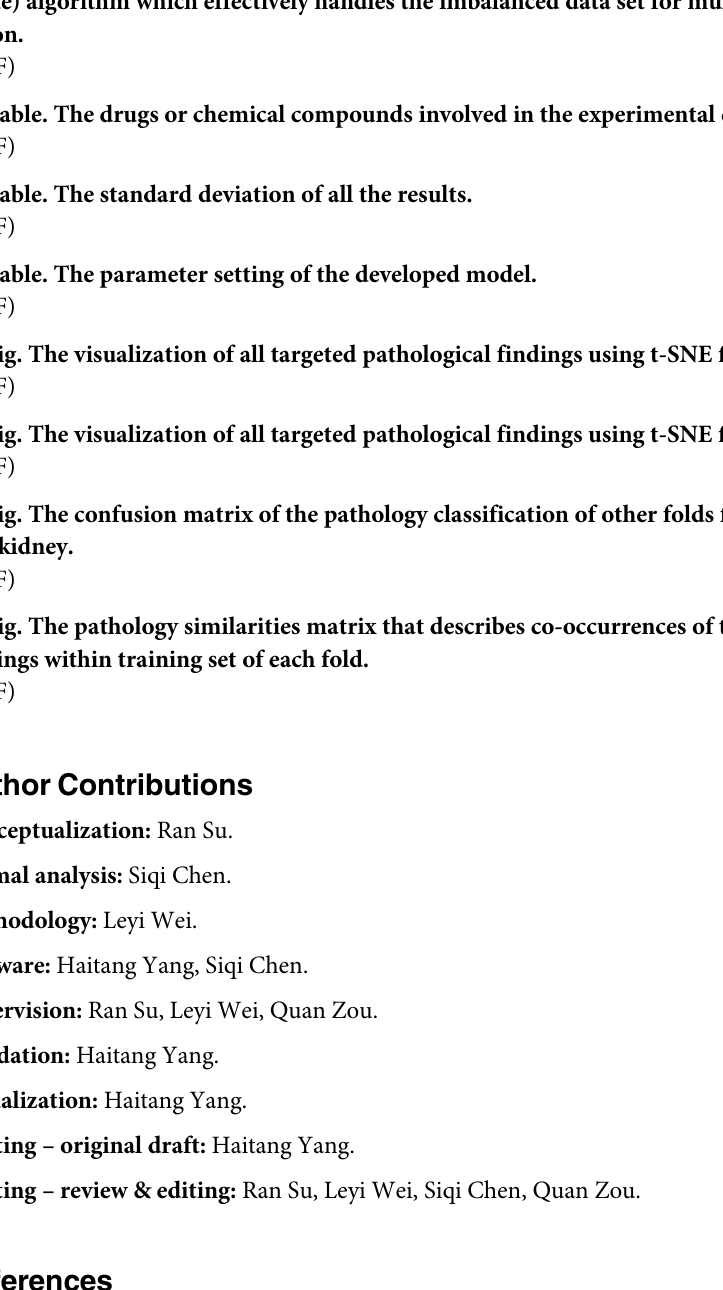
S1 Table. The drugs or chemical compounds involved in the experimental data. S2 Table. The standard deviation of all the results. S3 Table. The parameter setting of the developed model. S1 Fig. The visualization of all targeted pathological findings using t-SNE for liver. S2 Fig. The visualization of all targeted pathological findings using t-SNE for kidney. S3 Fig. The confusion matrix of the pathology classification of other folds for both liver and kidney. S4 Fig. The pathology similarities matrix that describes co-occurrences of two pathological findings within training set of each